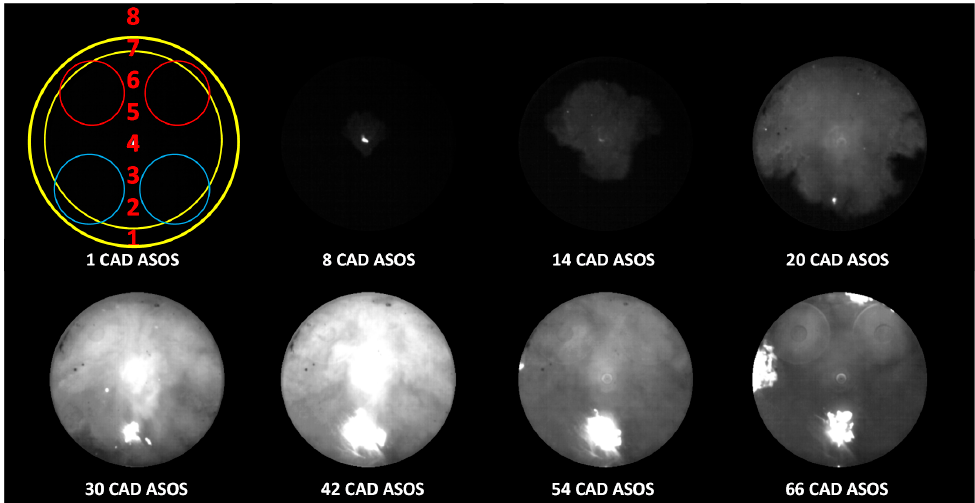
Figure 10. Images of flame evolution for stoichiometric operations.